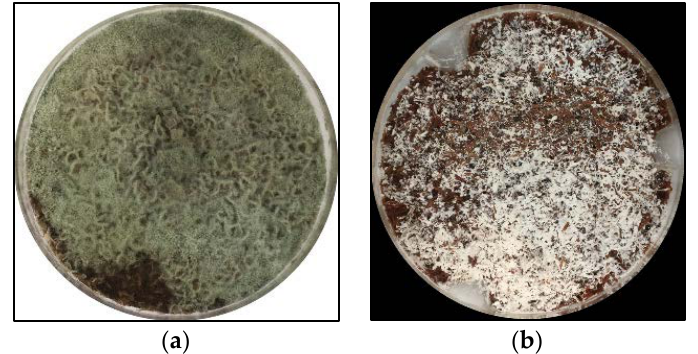
Figure 2. Solid-state fermentation after seven days ( a ) a mixed culture of Trichoderma reesei and Aspergillus niger on soybean hull; ( b) Phanerochaete chrysosporium on birch wood chip.